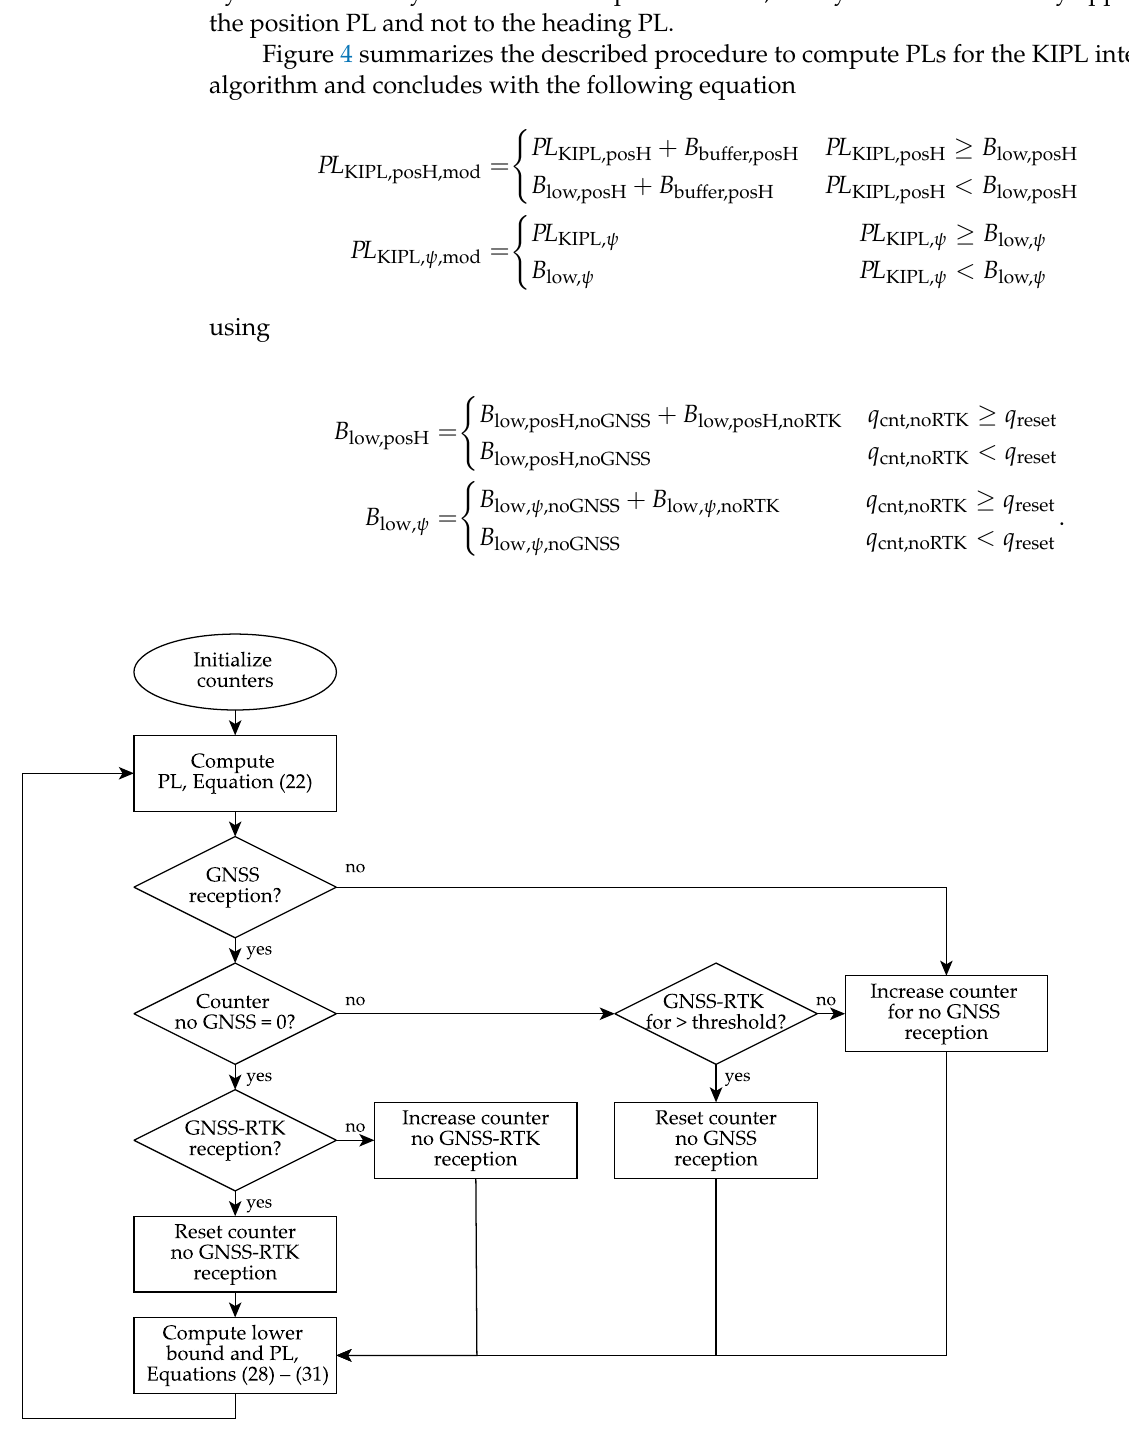
Figure 4. Flow chart of KIPL integrity algorithm PL